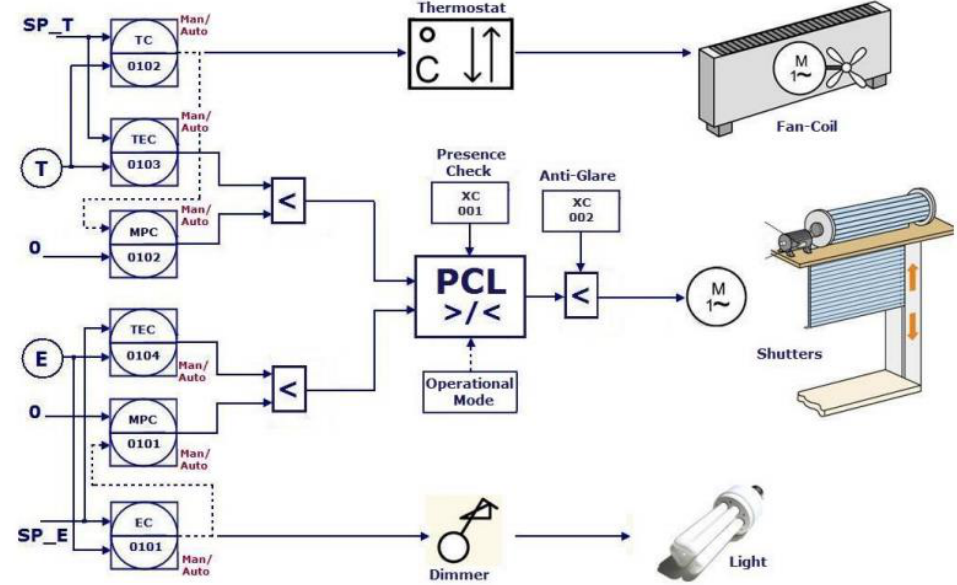
Figure 10. Architecture of the modified control system (thermal and lighting control).